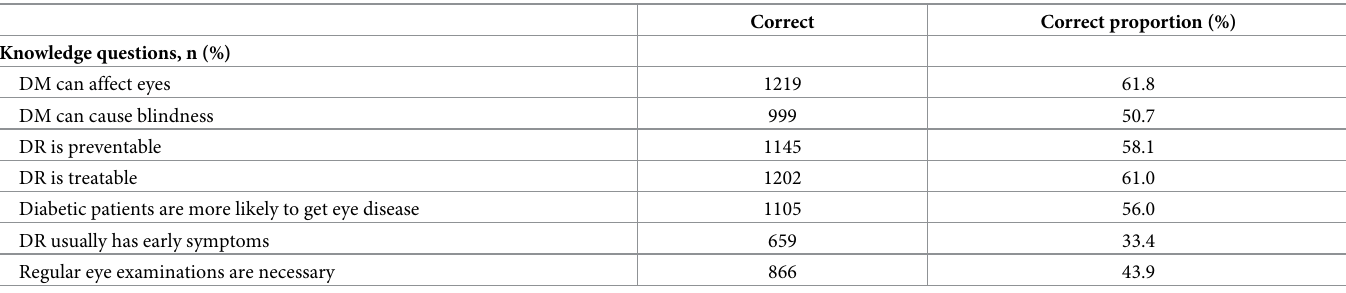
Table 4. Knowledge about diabetic retinopathy among diabetic patients (n = 1972).